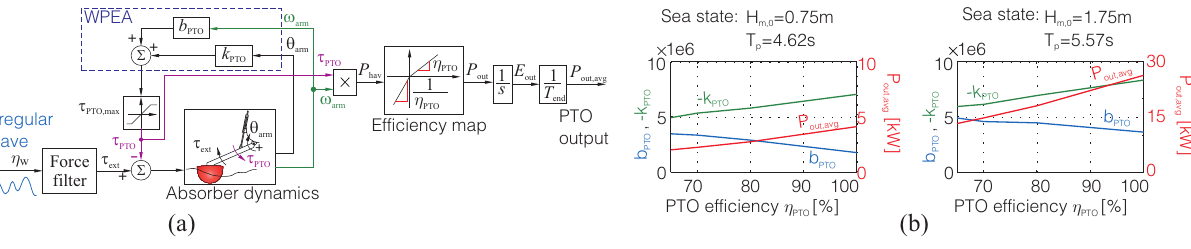
Figure 22. ( a ) model for reactive control optimization [8]; and ( b ) control parameters for two sea states as a function of PTO power conversion efficiency, η